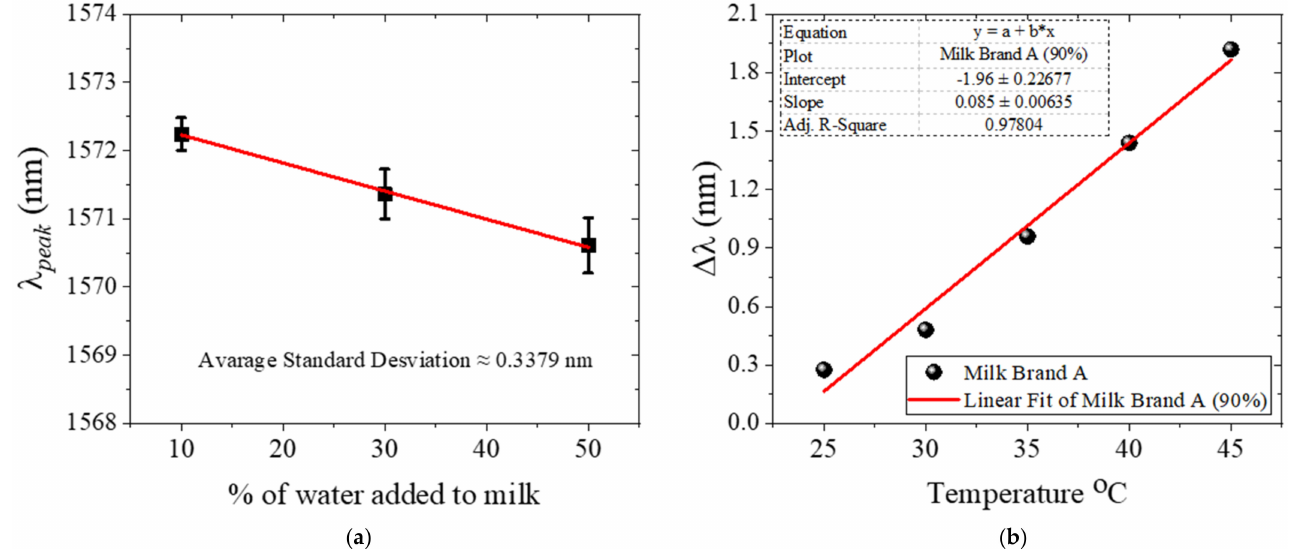
Figure 5. ( a ) Wavelength peaks measured for three representative water–milk mixtures (10/90, 30/70 and 50/50, respectively). Each wavelength reading was performed three times to verify the repeatability of the experiment. ( b ). Thermal effect measured at a concentration of 90% milk of brand A. Measurements were performed in the temperature range from 25 to 45 ◦ C in increments of 5 ◦